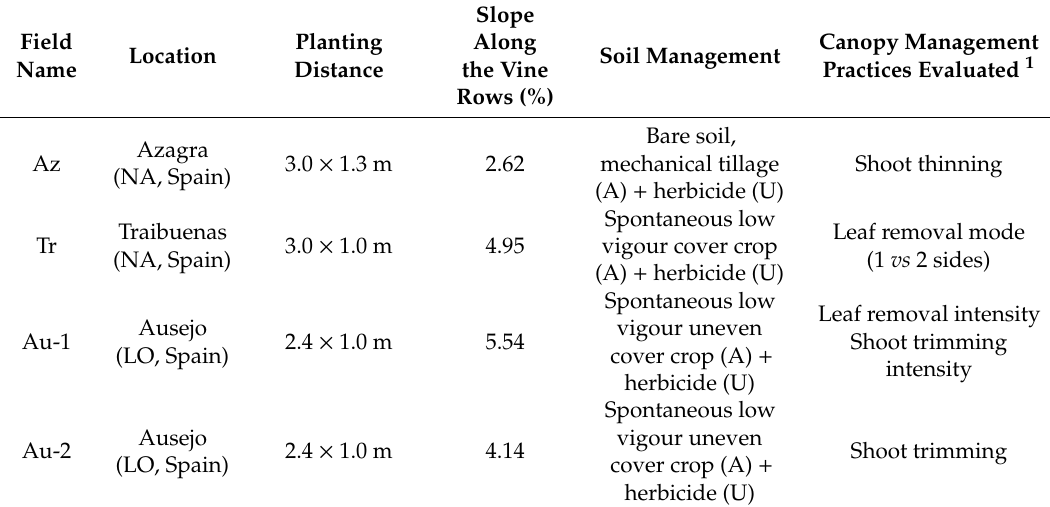
Table 1. Information about the study